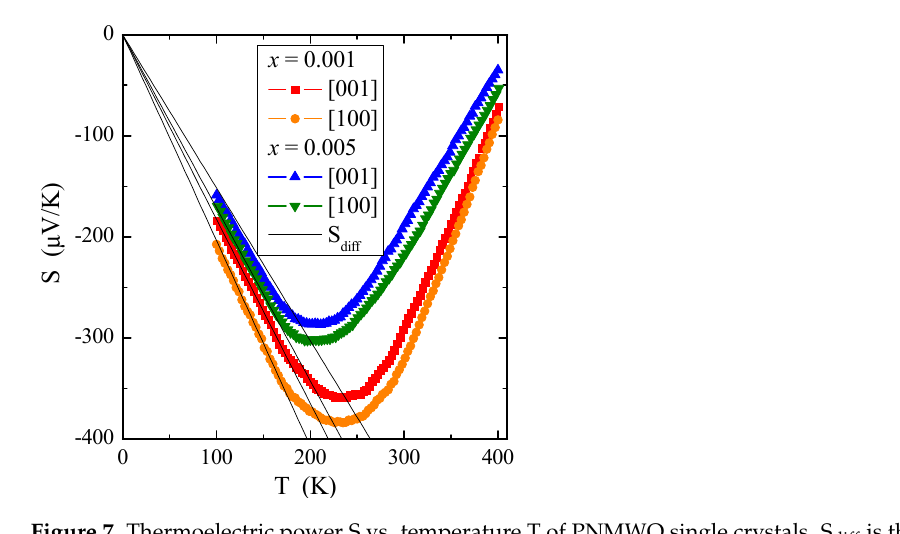
Figure 8. Power factor S 2 σ vs. temperature T of PNMWO single crystals.